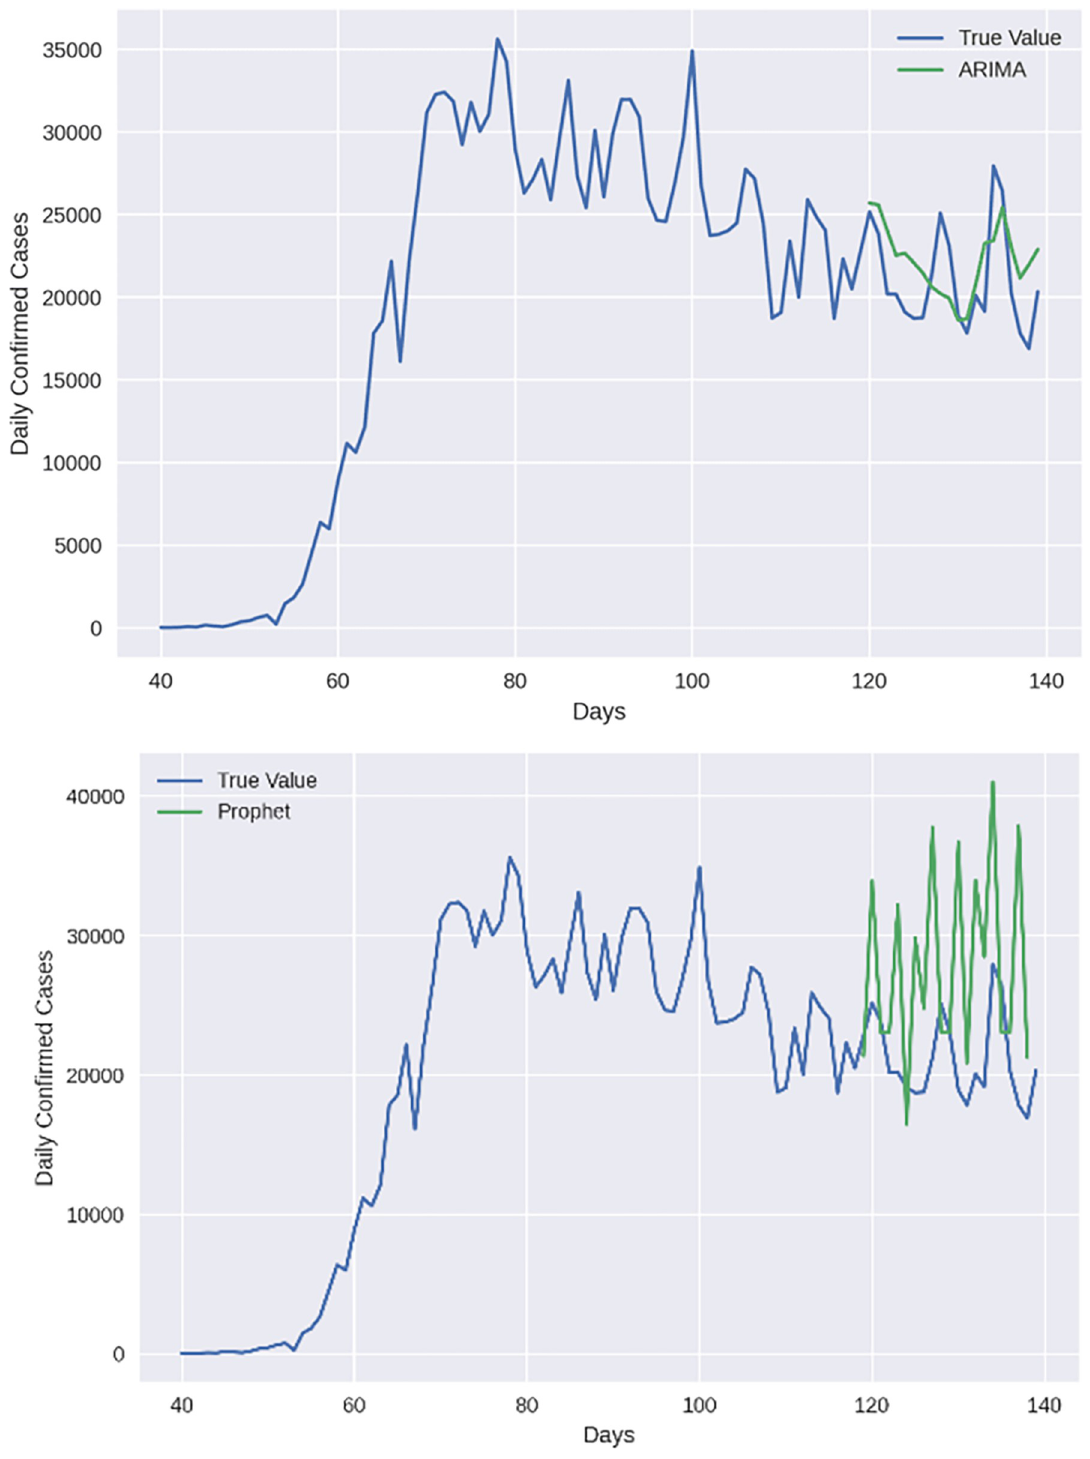
Fig 4. Comparison of the number of covid-19 cases prediction using (a) ARIMA and (b) FBProphet with True Value.